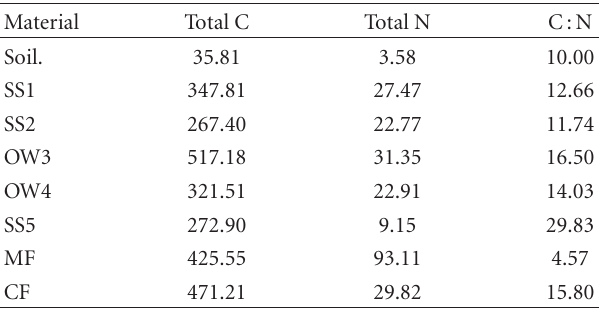
Table 1: Total C, total N and C:N ratio in the soil and the organic matters (gkg − 1 )DM) used in the laboratory incubation